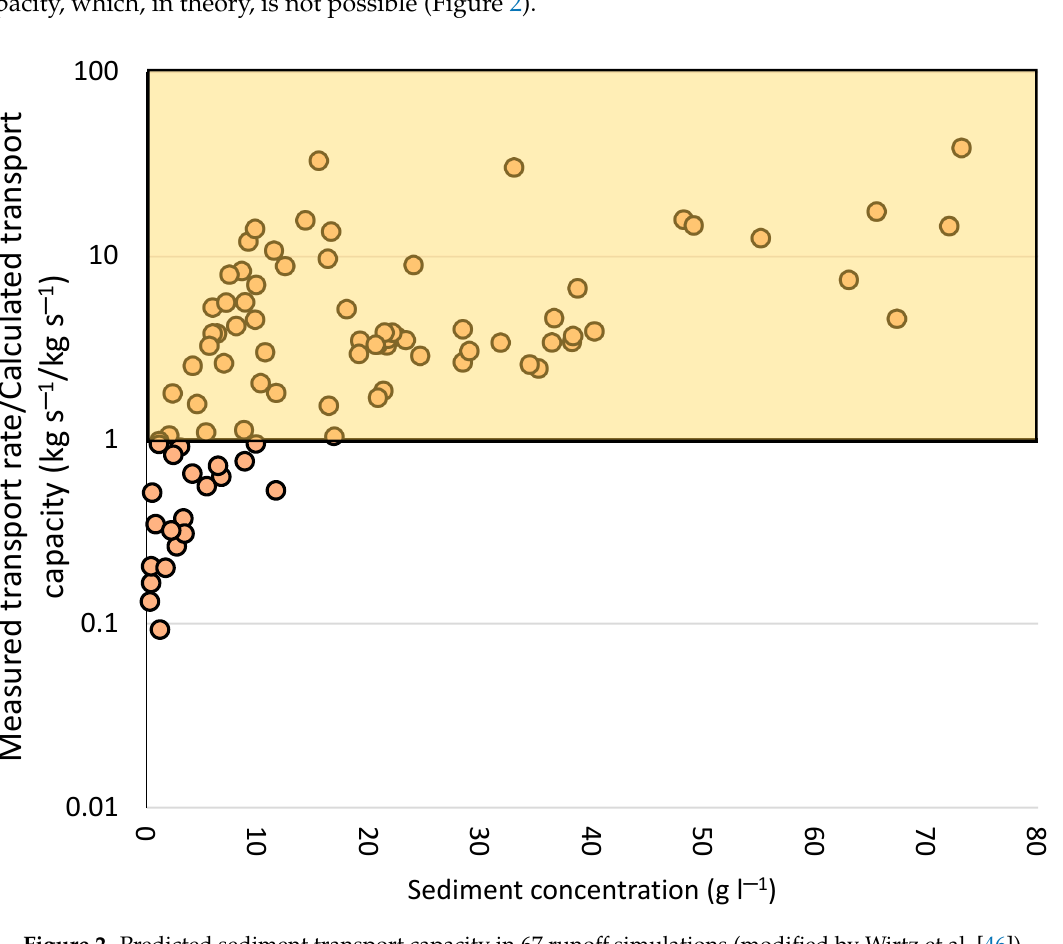
Figure 2. Predicted sediment transport capacity in 67 runo ff simulations (modified by Wirtz et al. [46]). Points in orange above 1 show the measured values that exceed the predicted maximum transport capacity. Values on the y -axis > 1: the rate is higher than the transport capacity).